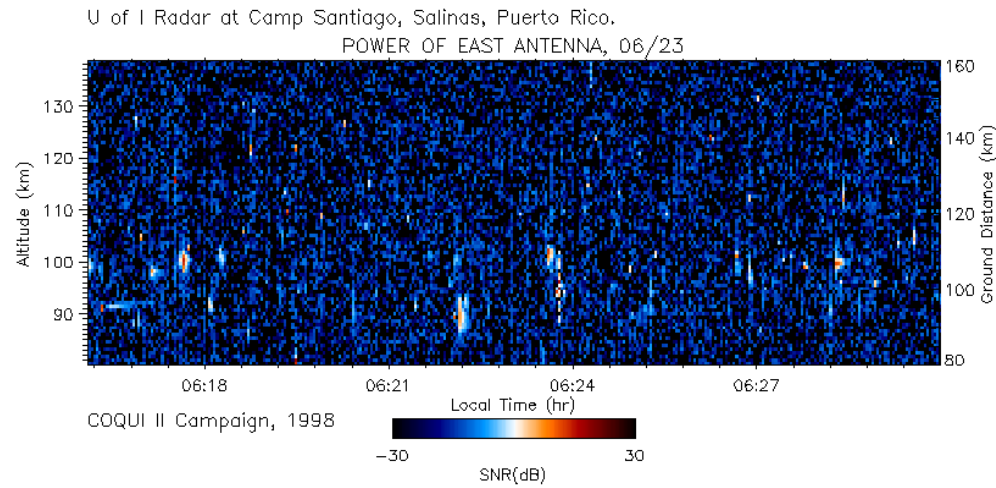
Figure 2. RTI images of meteor observations just before sunrise at 5:49 AST, on 6/23/1998 during the Fig. 2. RTI images of meteor observations just before sunrise at 05:49AST, on 23 June 1998 during the Coqui II campaign see Urbina et Coqui II campaign see Urbina et al. [2000] for more information on the radar and campaign. Each bright al. (2000) for more information on the radar and campaign. Each bright spot extended in multiple range bins and for multiple time bins spot extended in multiple range bins and for multiple time bins represents a non-specular meteor trail. represents a non-specular meteor trail.